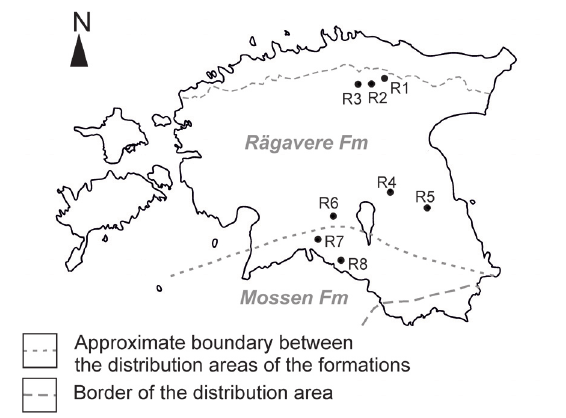
Fig. 4. Distribution of the Rakvere RS and the location of the studied sections. The distribution of the Mossen Fm has been drawn based on the latest observations (Meidla et